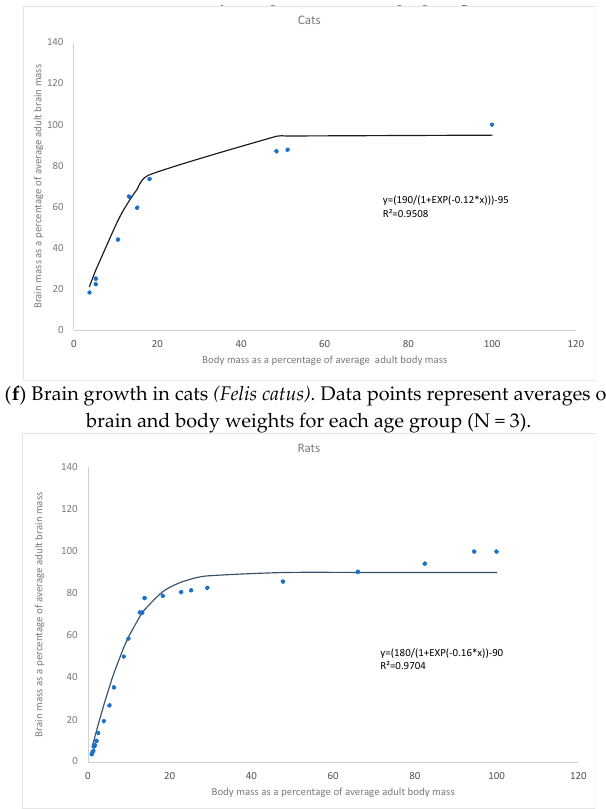
( g ) Brain growth in rats (Rattus norvegicus , black hooded). Data points represent averages of brain and body weights for each age group (N = 6–37).